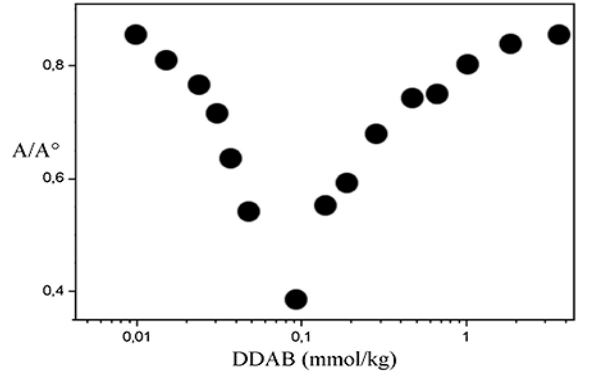
Figure 4. Absorbance, at 660 nm, of 0.01 wt% ss-DNA/SWCNT dispersions of 1/1 complex vs. DDAB concentration, at 25 °C. The minimum is the charge neutralization.